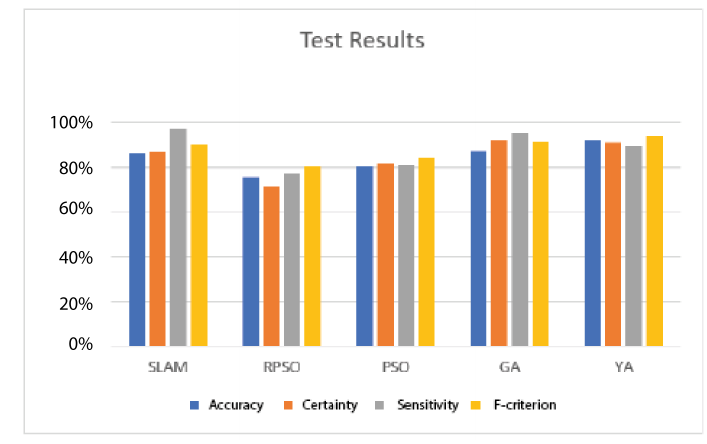
Figure 12. Algorithm Test Results.